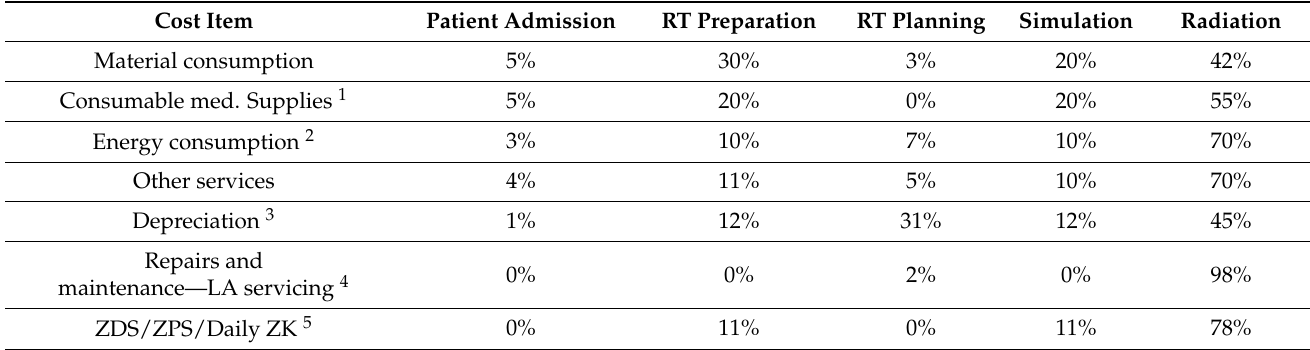
Table 6. The percentage distribution of cost items among component activities based on actual usage.